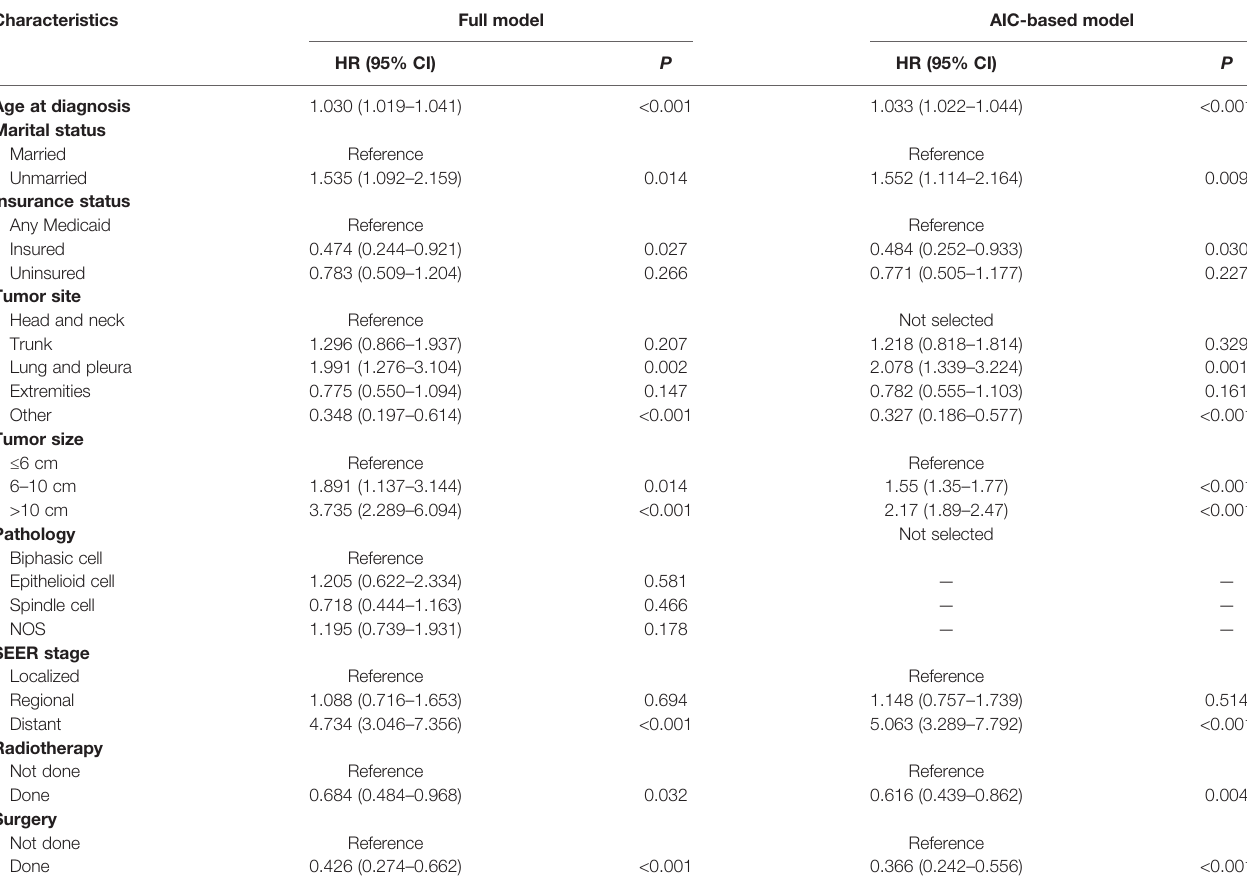
TABLE 3 | Multivariate Cox regression analysis for OS of the SyS patients in the training cohort. Characteristics